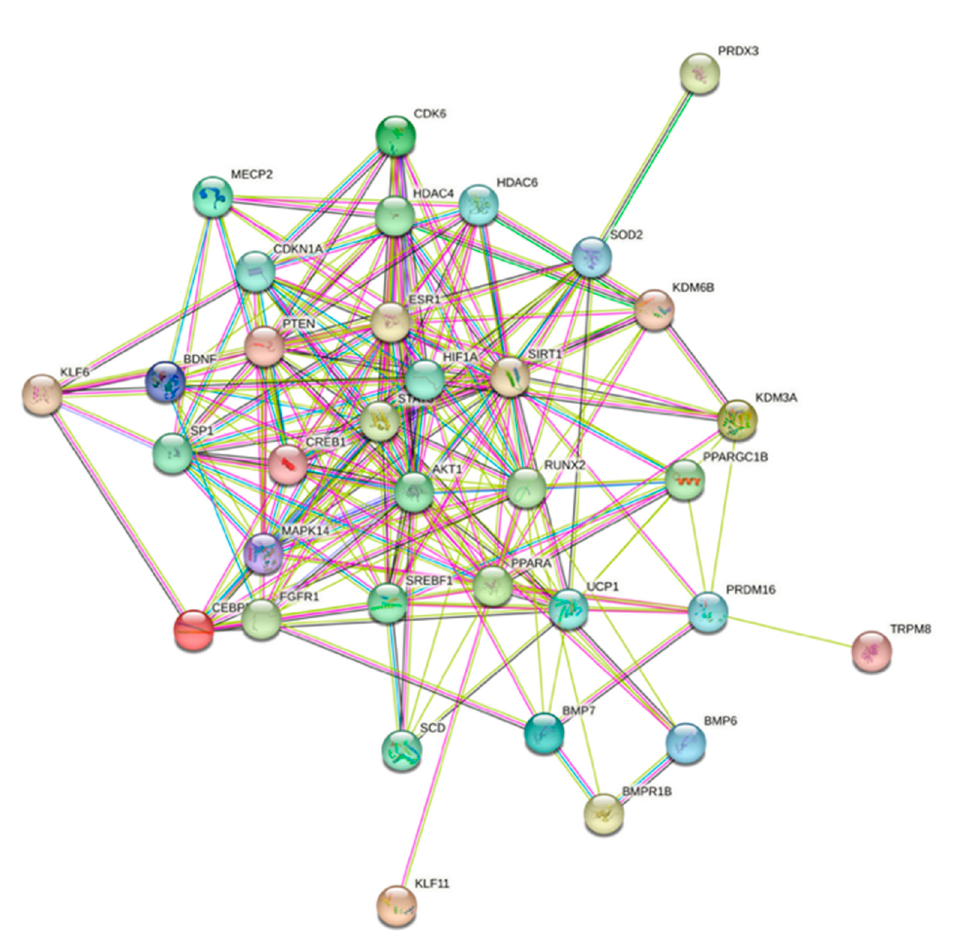
Figure 4. Prediction of protein–protein interaction networks related to miR-22 using the protein– protein interaction-networks functional enrichment analysis tool String (https://string-db.org (ac- cessed on 3 July